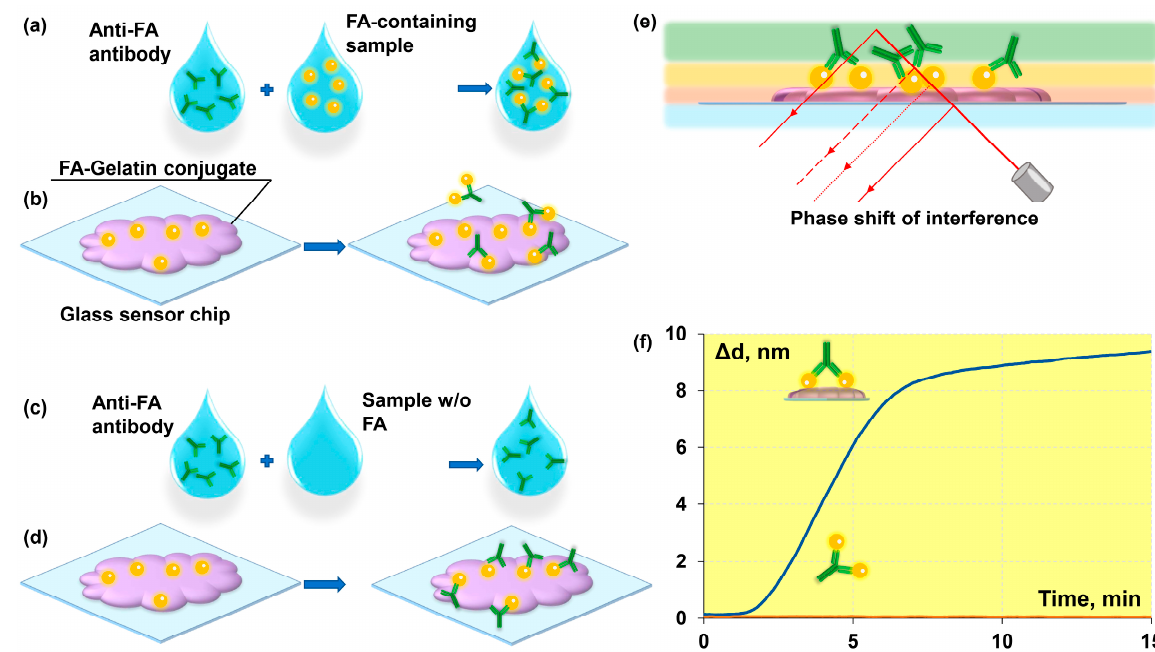
Figure 2. Scheme of the assay procedure for real-time detection of folic acid with spectral correla- tion interferometry: ( a ) FA antibodies are added to the analyzed sample that contains FA antigen; ( b ) FA antibodies do not bind via the occupied antigen-binding sites with the surface of the glass sensor chip, on which FA − gelatin conjugate is immobilized; ( c ) FA antibodies are added to the an- alyzed sample that does not contain FA antigen; ( d ) FA antibodies bind via free antigen-binding sites with the surface of the glass sensor chip, on which FA − gelatin conjugate is immobilized; ( e ) schematic of the operation principle of the chemosensor based on the spectral correlation interferometry: a phase shift between the beam reflected from the bottom surface of the sensor chip and the beam reflected from the interface “biolayer − liquid sample”; ( f ) sensorgrams that show the typical responses in real-time from the SCI chemosensor during analyses of the samples which contain (lower red line) and do not contain FA antigen (upper blue